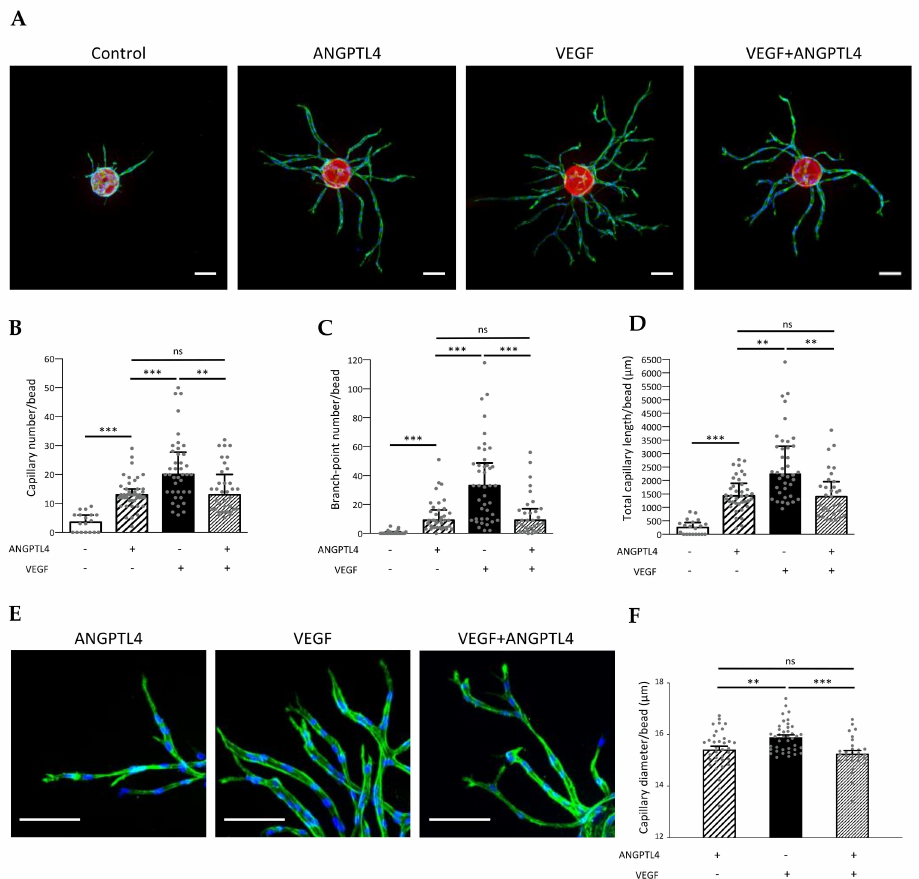
Figure 1. Regulation of 3D capillary morphogenesis by ANGPTL4. ( A ) 3D capillary formation was assessed after 4 days of culture in absence (control) or presence of ANGPTL4 (2.5 µ g/mL) and/or VEGF (2.5 ng/mL). Capillaries sprouting from fluorescent bead (red) were stained for F- actin (green) and nuclei (blue). Scale bar: 100 µ m. ( B ) Median values of capillary number/bead (+interquartile). ( C ) Median values of branch-point number/bead (+interquartile). ( D ) Median values of total capillary length/bead (+interquartile). ( E ) Capillaries stained for F-actin (green) and nuclei (blue). Scale bar: 100 µ m. ( F ) Mean values of capillary diameter/bead (+SEM). Values were measured in three independent experiments of at least triplicate wells. ns: p > 0.05, ** p ≤ 0.01, *** p ≤ 0.001 (( B – D ): Kruskal–Wallis, ( F ): one-way